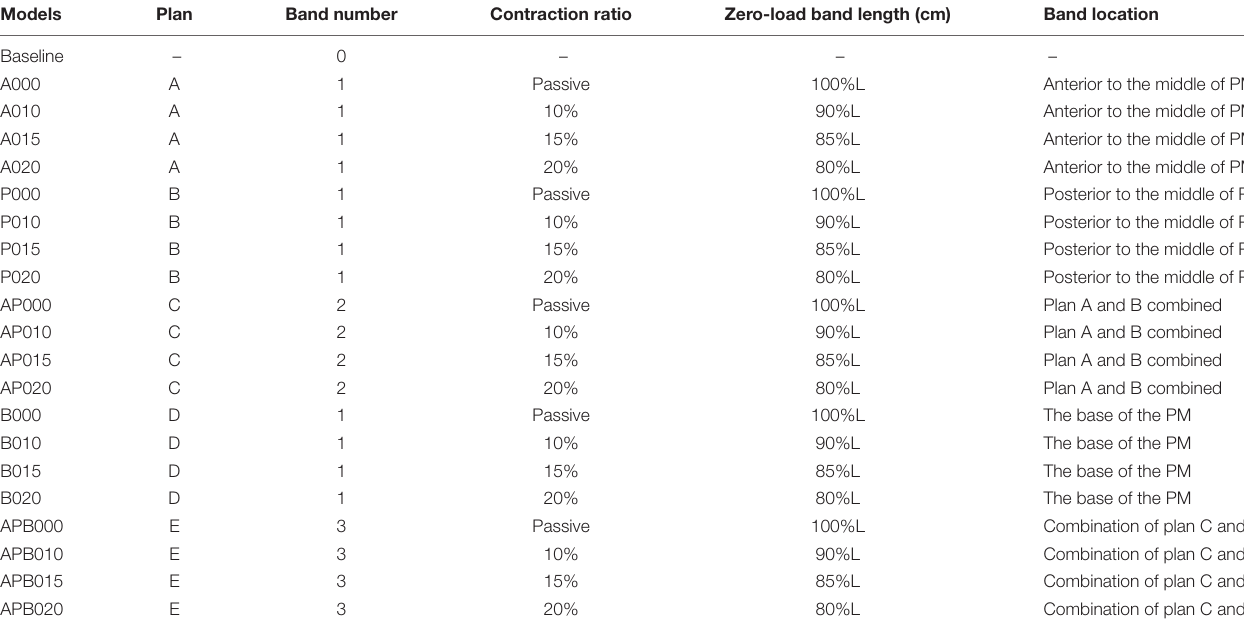
TABLE 2 | Band model summary, band location and numbers, contraction ratios, and zero-load band length for all 21 RV/LV models. Models Plan Band number Baseline